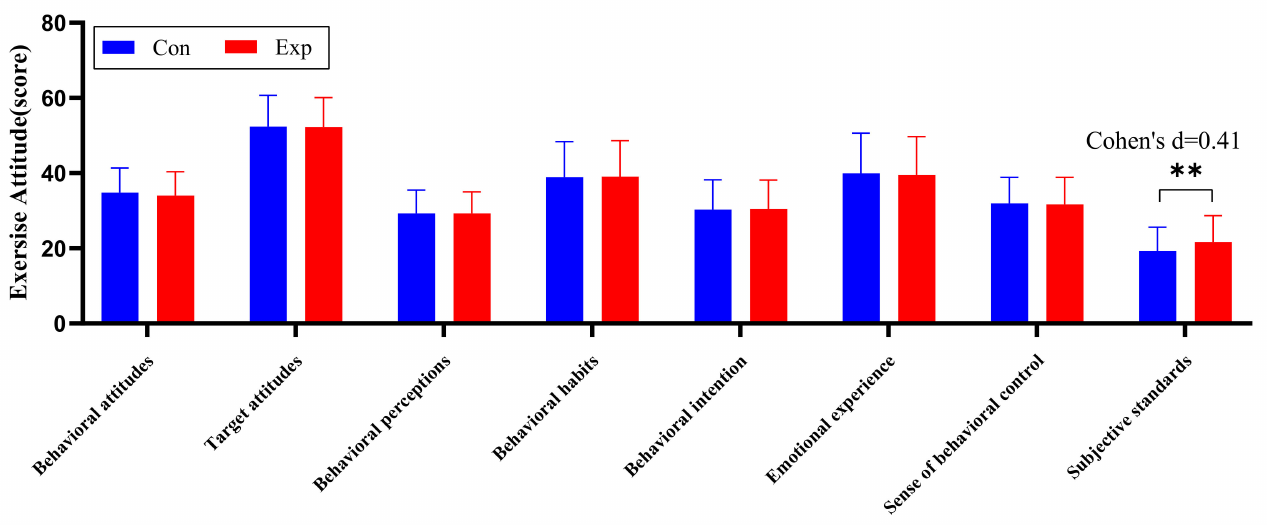
Figure 8. Descriptive statistics and between-group variations of means of exercise attitude. **: p <